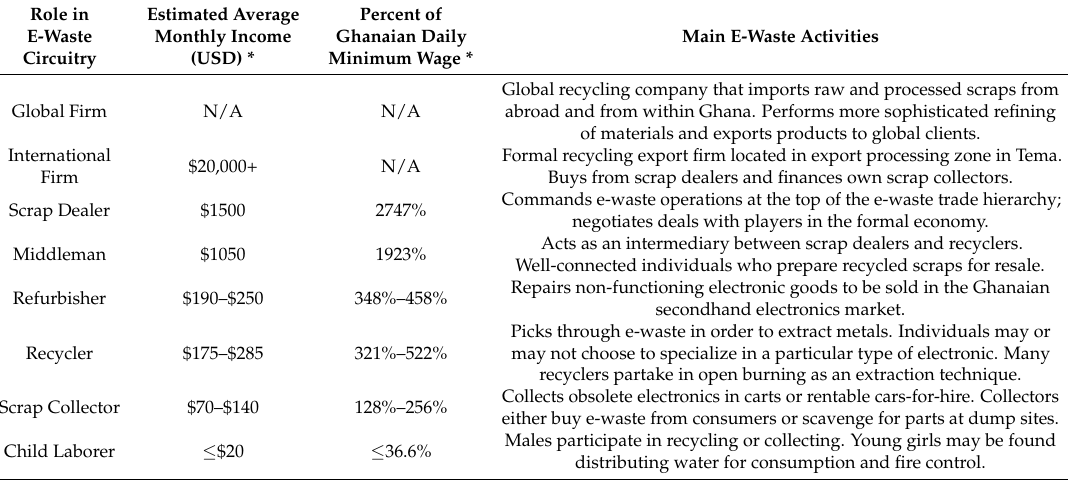
Table 1. Hierarchical structure of e-waste labor segments, with worker incomes reported from